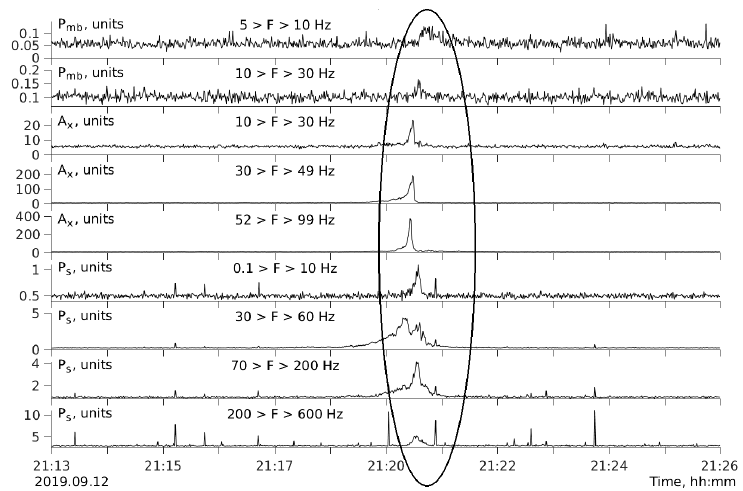
Figure 7: Atmospheric acoustic signal variations P mb recorded by the microbarometer, geoa- coustic signal A x recorded by the geophone (X component), geoacoustic signal P s recorded by the hydrophone № 1 of high-frequency geoacoustic system from 21:13 to 21:26 UT on September 12, 2019. Ellipse shows the simultaneous amplitude jump